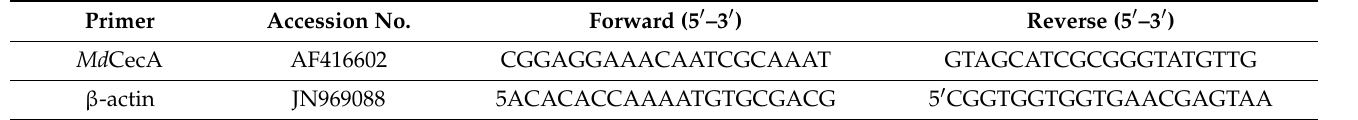
Table 1. Sequences of the primers used in the